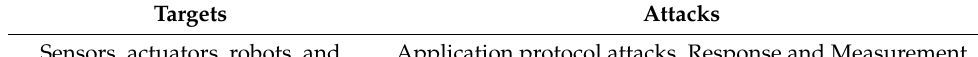
Table 3. Targets and Attacks. Targets Attacks Sensors, actuators, robots, and Application protocol attacks, Response and field devices